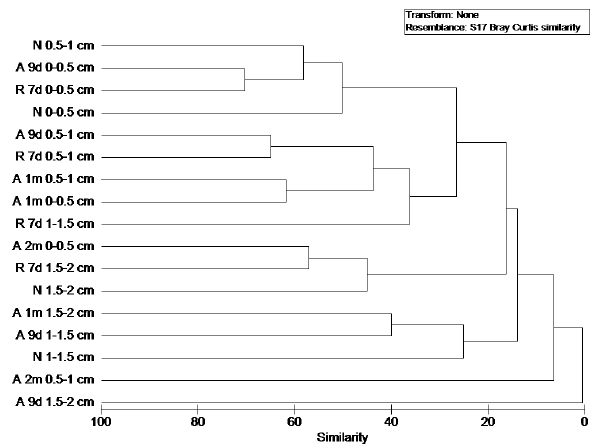
Fig. 6. Dendrogram of the Bray–Curtis similarity between sam- ples (different treatments and different depths). N = normoxia, A = anoxia, R = recovery, duration of treatment: 7days, 9days, 1month, 2months). Triplicates averaged per depth